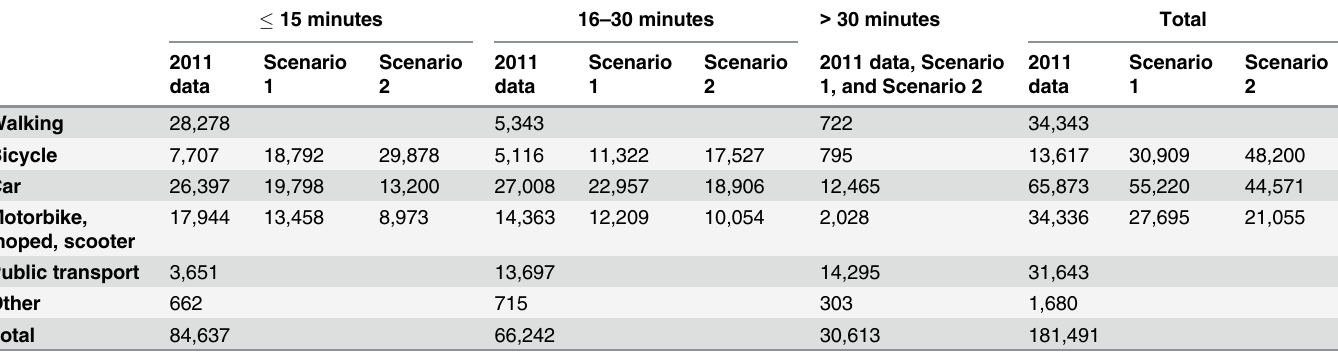
Table 8. Individuals commuting to work or school in Florence, by mode of transport and travel time, 2011 population census data and cycling pro- motion scenario analysis (rounded